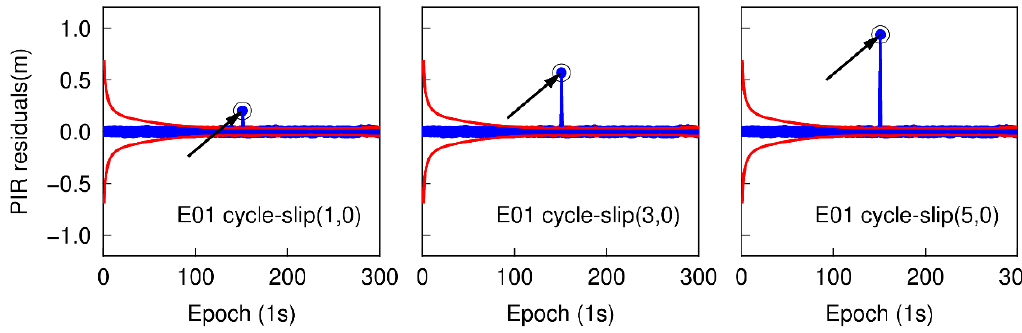
Figure 6. Small cycle-slip detection results using PIR combination for E01.